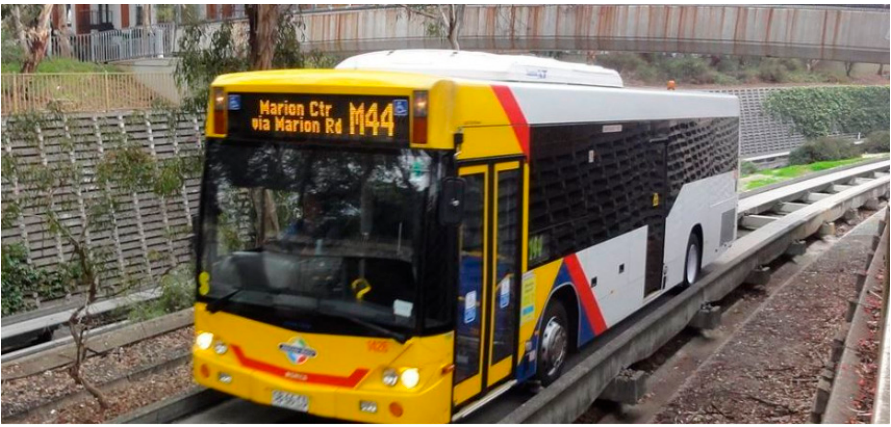
Figure 8. Adelaide’s BRT system.